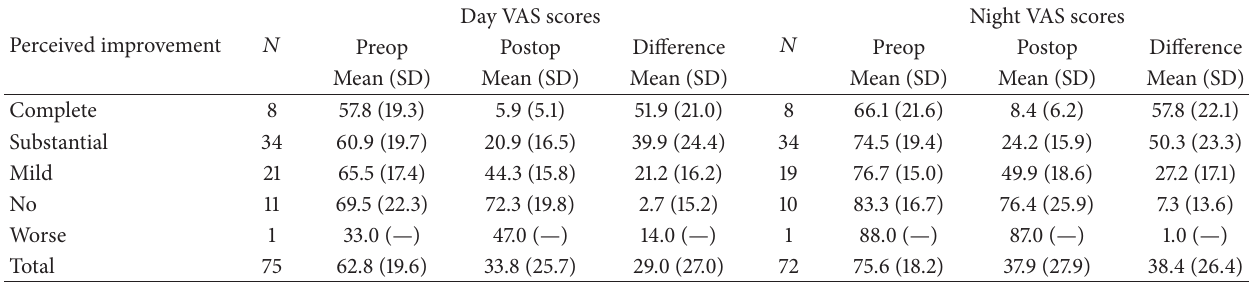
Table 2: Results of surgery. Pre- to postoperative change in day and night VAS scores for each level of perceived improvement in nasal breathing.